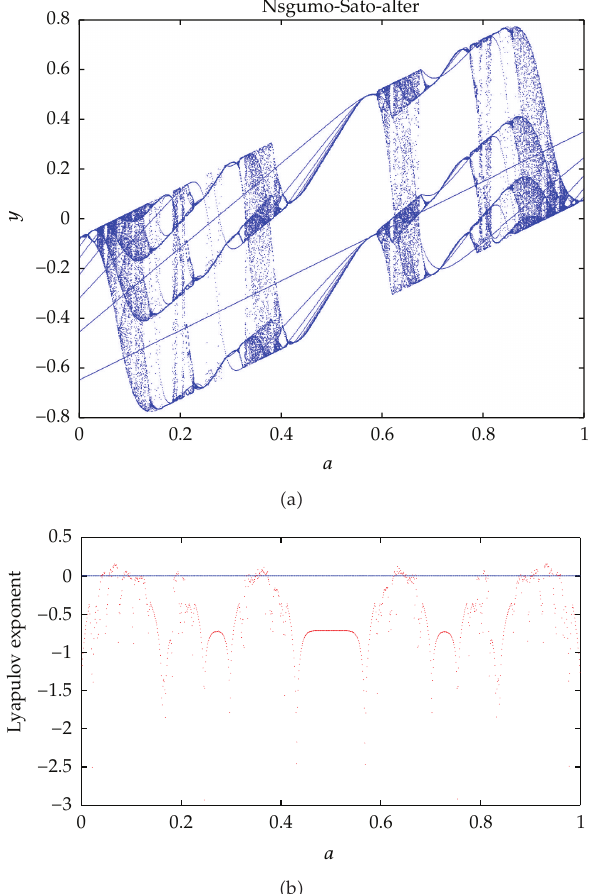
Figure 2: Response characteristics diagram of (cid:3) 2.3 (cid:4) : (cid:3) a (cid:4) the bifurcation structure; (cid:3) b (cid:4) the Lyapunov